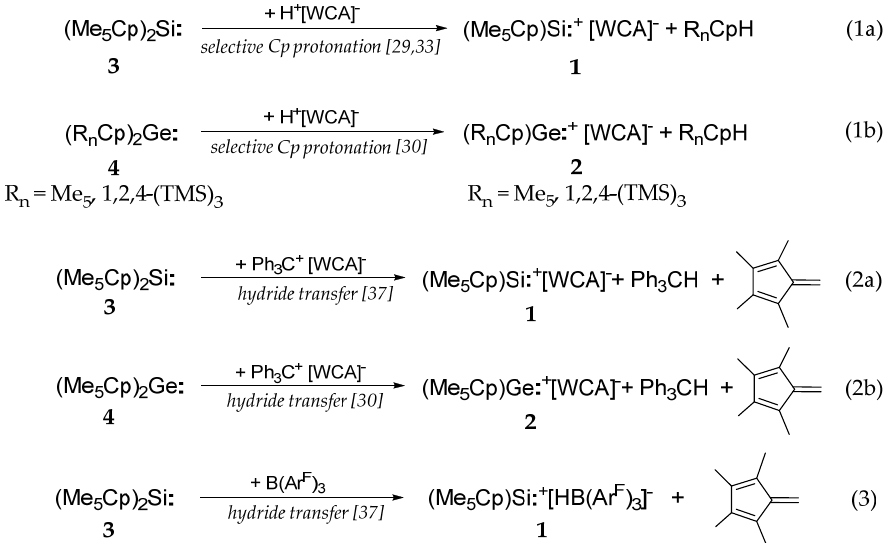
Table 1. Synthesis of catalysts 1 and 2 by selective protonation of tetrelocenes 3 and 4 .